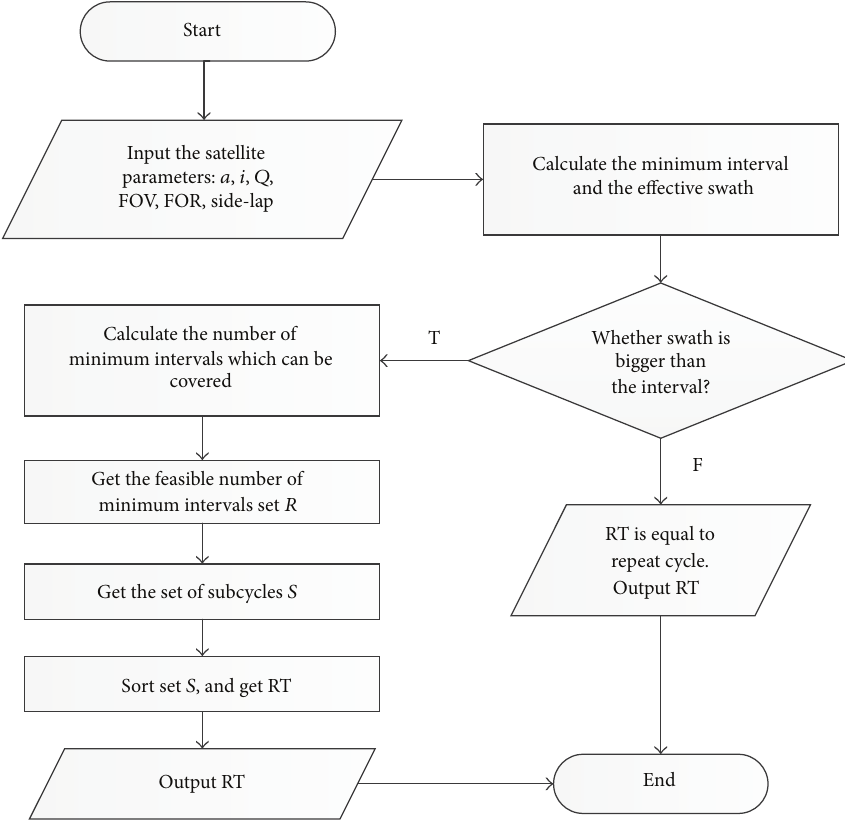
Figure 6: The procedure to compute the revisit time of a